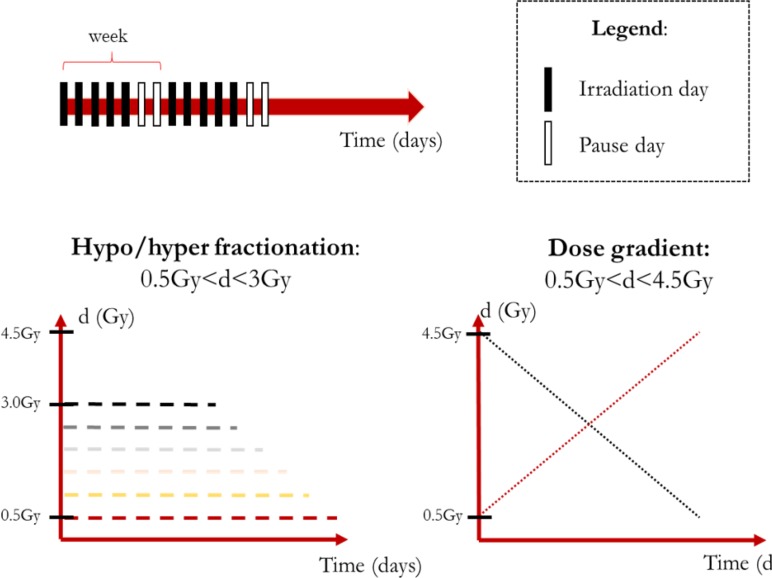
Summary of the simulation scheme.